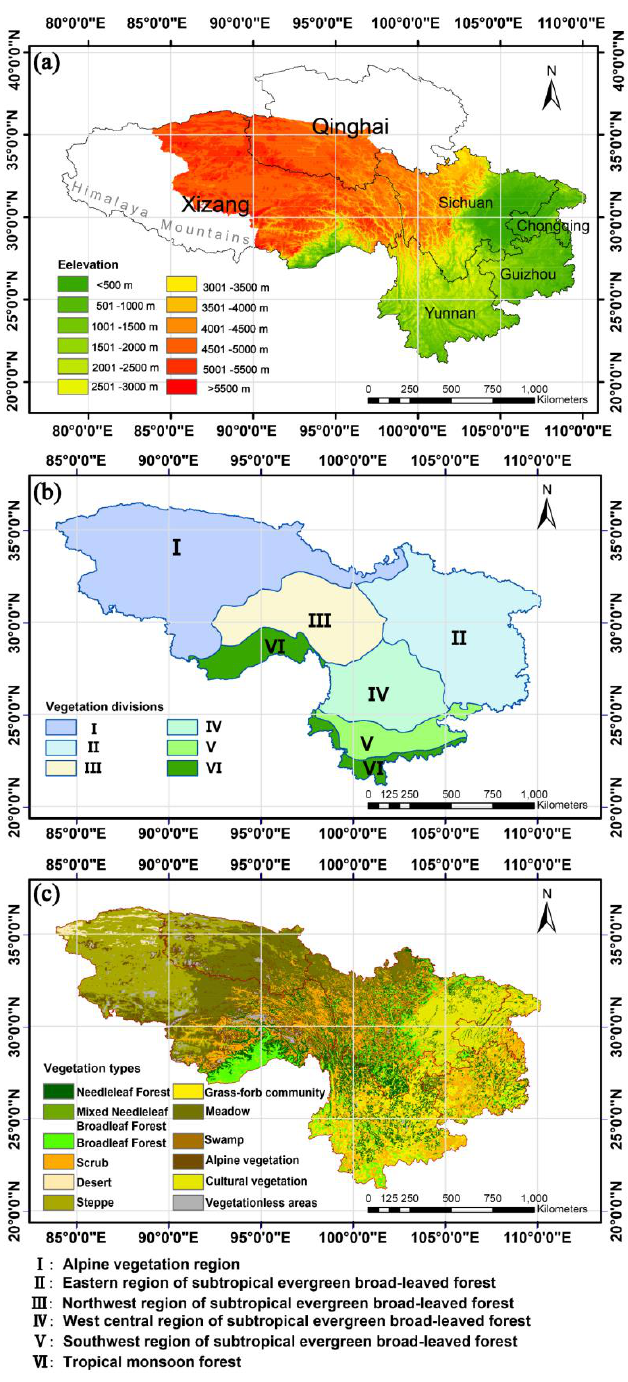
Figure 1. Outline of: ( a ) Geography; ( b ) vegetation divisions; and ( c ) vegetation types in the SW region.